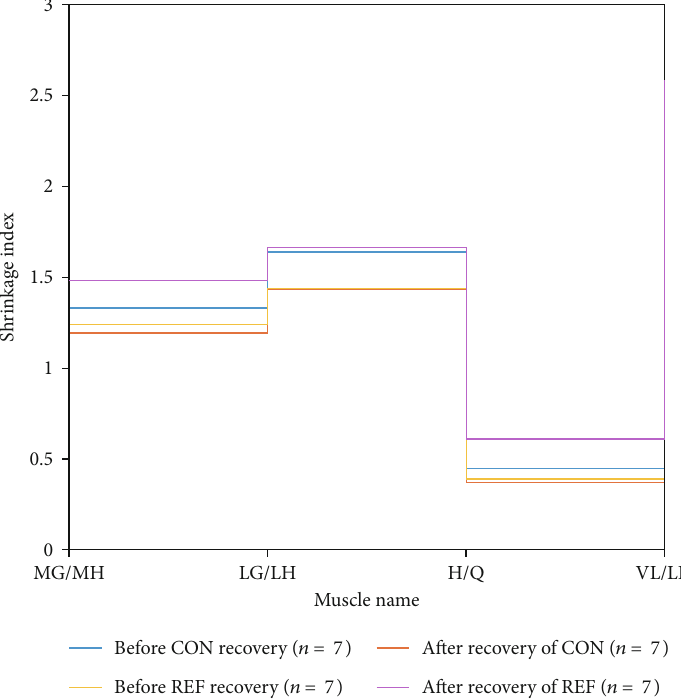
Figure 4: Comparison of the common contraction index of di ff erent muscle groups of female olive athletes before and after rehabilitation